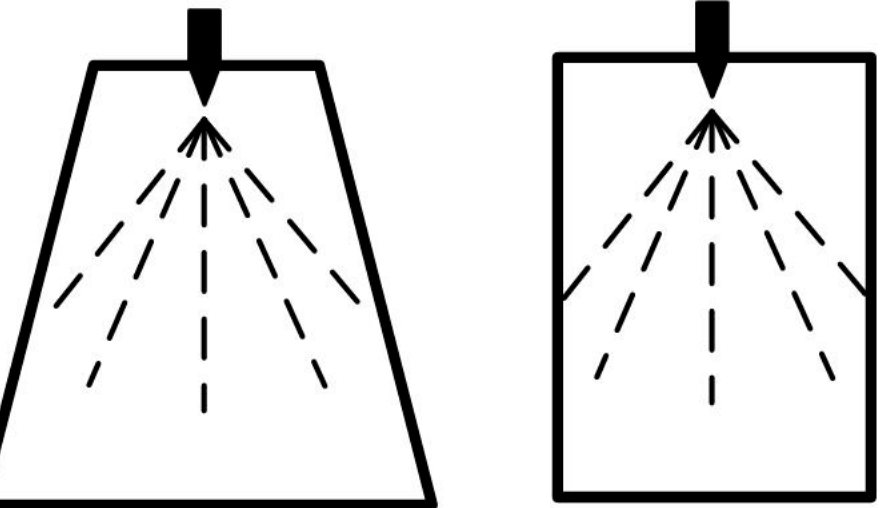
Figure 6. Difference between cylindrical and conical drying chambers.